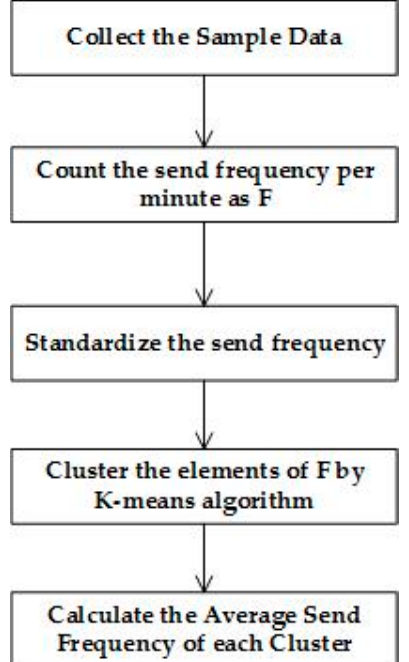
Figure 4 . Analysis of sample datasets. Figure 4. Analysis of sample